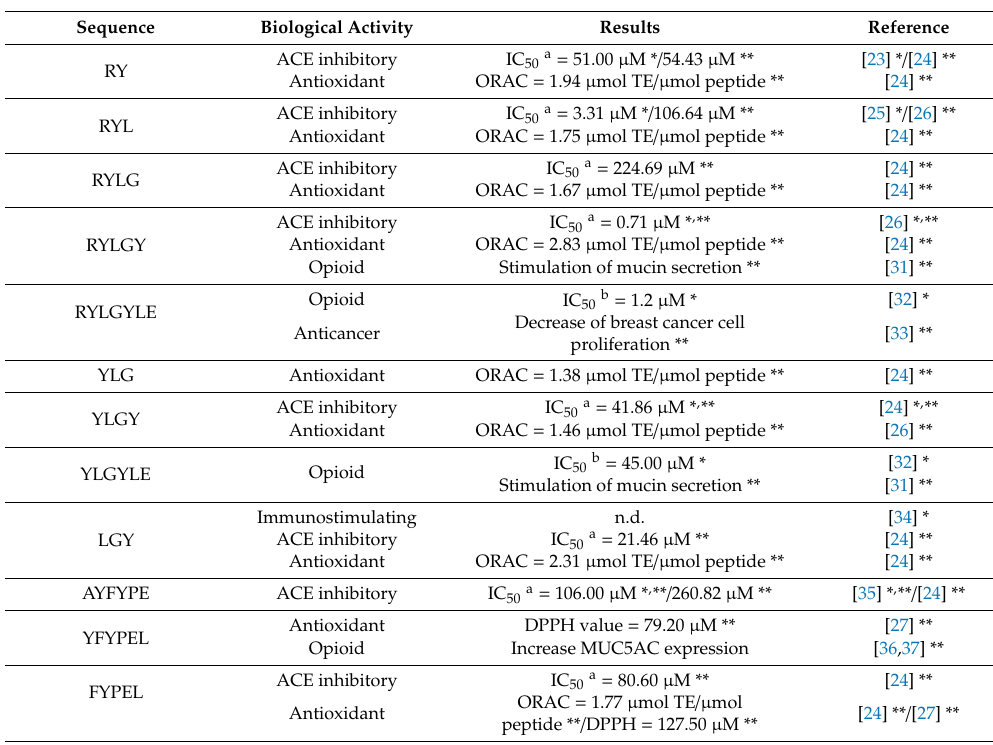
Table 3. Predicted biological activity of synthetic peptides derived from food sources using Milk Bioactive Peptide Database (MBPDB) and BIOPEP-UWM database of bioactive peptides.